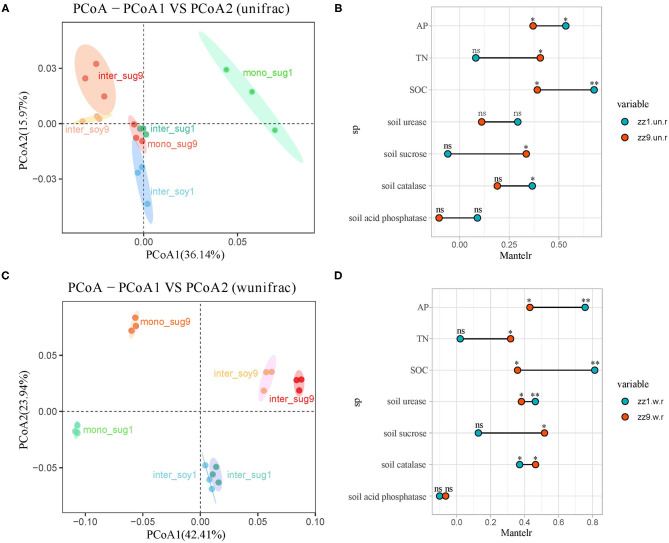
(A,C) Principal coordinate analyses (PCoAs) using UniFrac distance matrix, to analyze the differences in the diversity of bacterial beta under different patterns, (A) is unweighted, (C) is weighted. (B,D) Mantel test was used to o compare the correlation difference of soil nutrients between ZZ1 and ZZ9, (B) is unweighted, and (D) is weighted. P > 0.05 (NS), *P < 0.05, **P < 0.01.